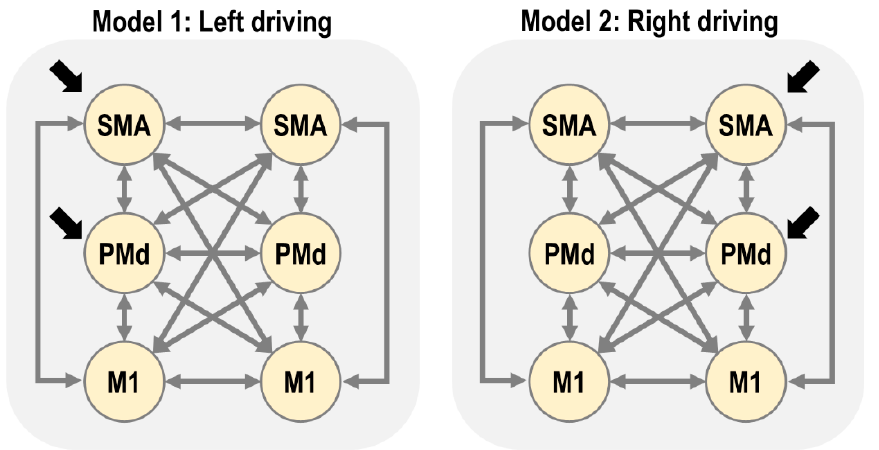
Figure 2. Candidate network architectures. The lighter arrows indicate connections among regions (matrix 𝑨 of the DCM neural model, Equation (1)) and the darker arrows indicate the location of driving inputs (matrix 𝑪 of the DCM neural model). Self-connections on each region are present but not shown. The left hemisphere of the brain is on the left of each diagram (and in all subsequent figures). SMA = supplementary motor area, PMd = dorsal premotor cortex, M1 = primary motor cortex.